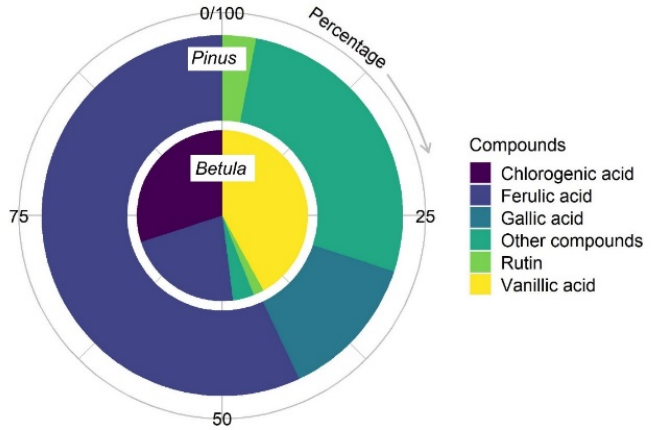
Figure 6. Relative distribution of phenolic compounds in bound PC extracts of Betula and Pinus pollen.